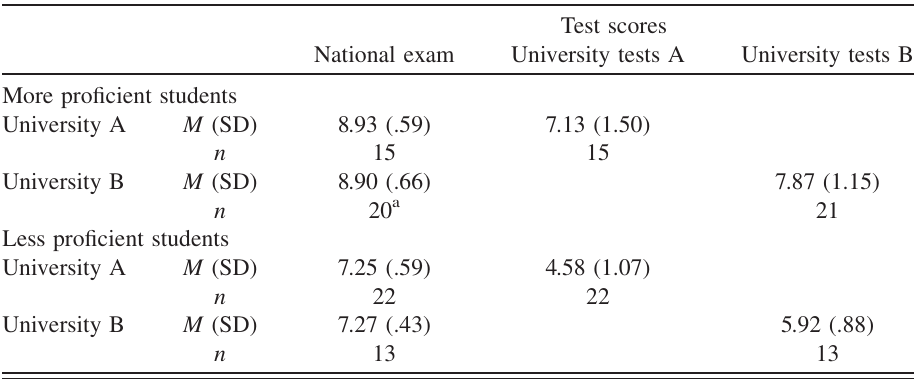
TABLE I. Mean test scores of more and less proficient groups. Note that all test scores are on a scale of 1 to 10, higher scores are better, 6 is the threshold between pass and